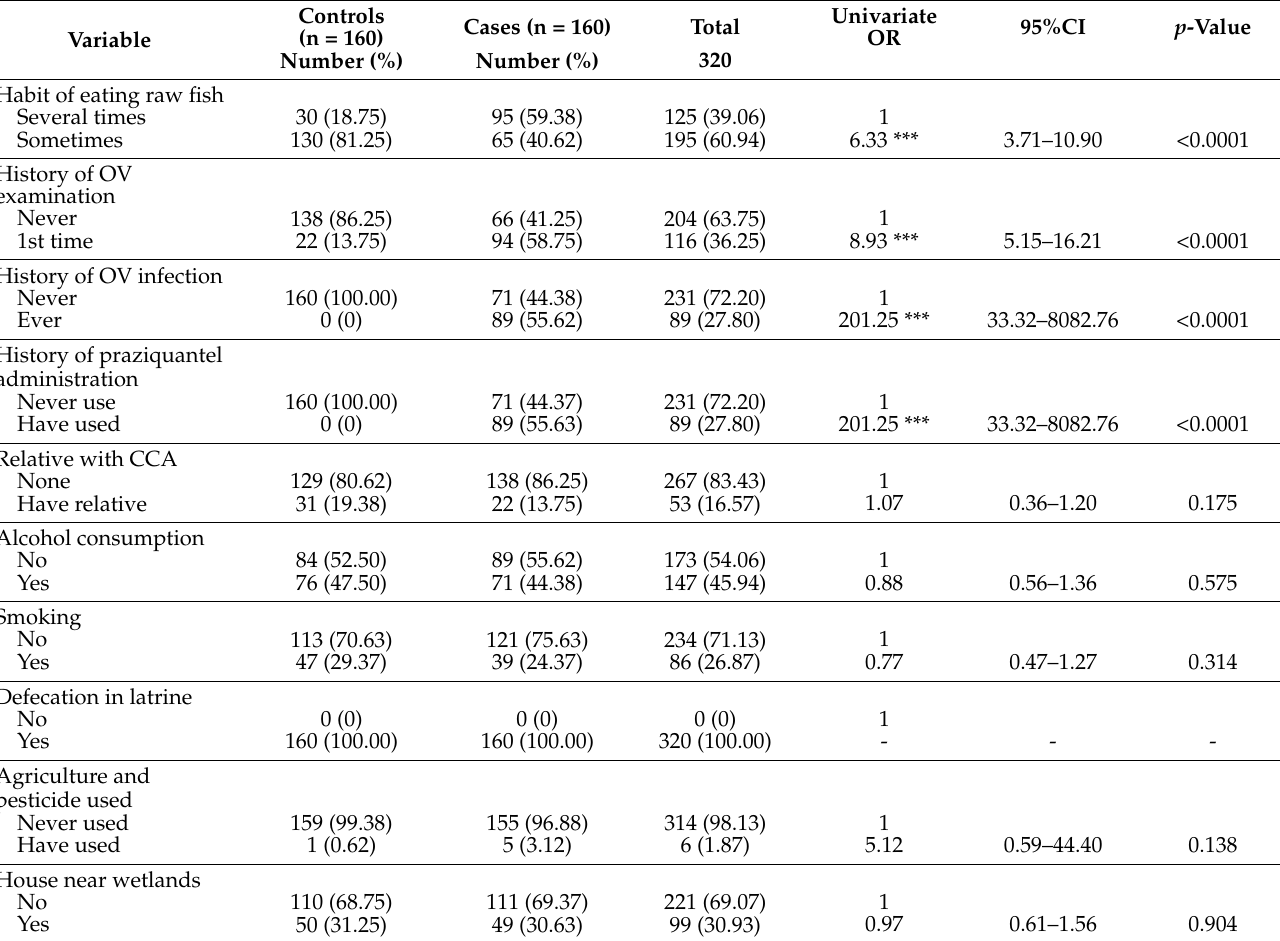
Table 2. Behavior factors associated with O. viverrini infection in Sakon Nakhon province, northeast- ern